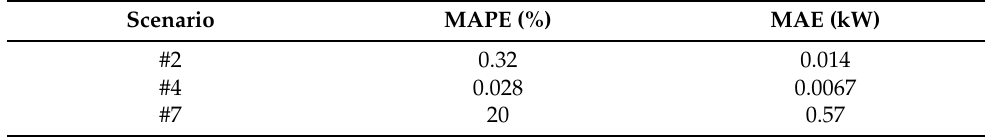
Table 2. MAPE and MAE values with and without considering the battery bank.